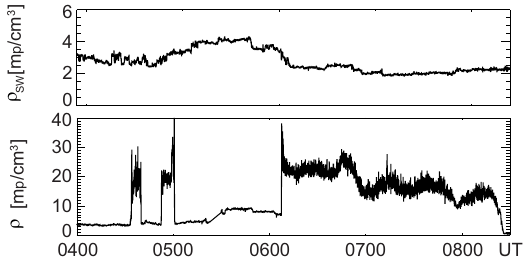
Fig. 9. The solar wind density measured by THEMIS B and the density measured by THEMIS C crossing the bow shock several times. The absolute values of the solar wind density do not fit well. This might be explained by a non-vanishing spacecraft potential; however, the relative variations can be considered. Note that the density jump measured by THEMIS C at about 05:30UT is related to a mode change of the ESA plasma instrument of the spacecraft (McFadden et al., 2008).